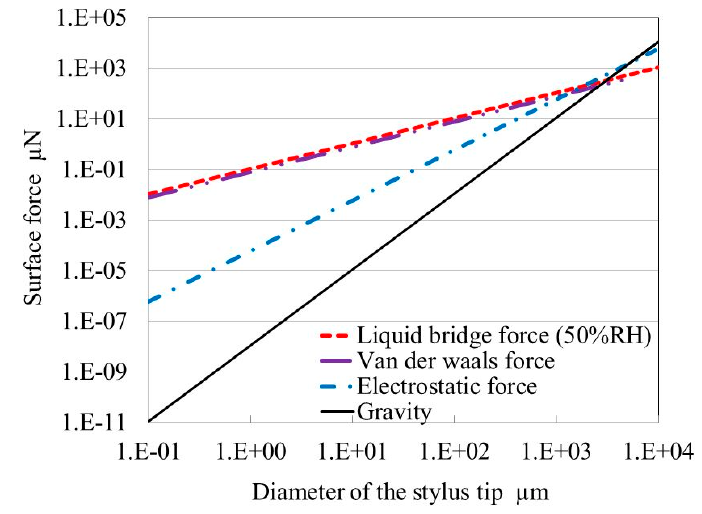
Figure 6. Relationship between stylus tip diameter and surface forces: A (SiO 2 ) = 1.5 × 10 − 20 J, z = 0.4 nm, ε 0 = 8.85 ˆ 10 ´ 12 F ¨ m ´ 1 , ε = 8 , σ = 26.5 µ C ¨ m ´ 2